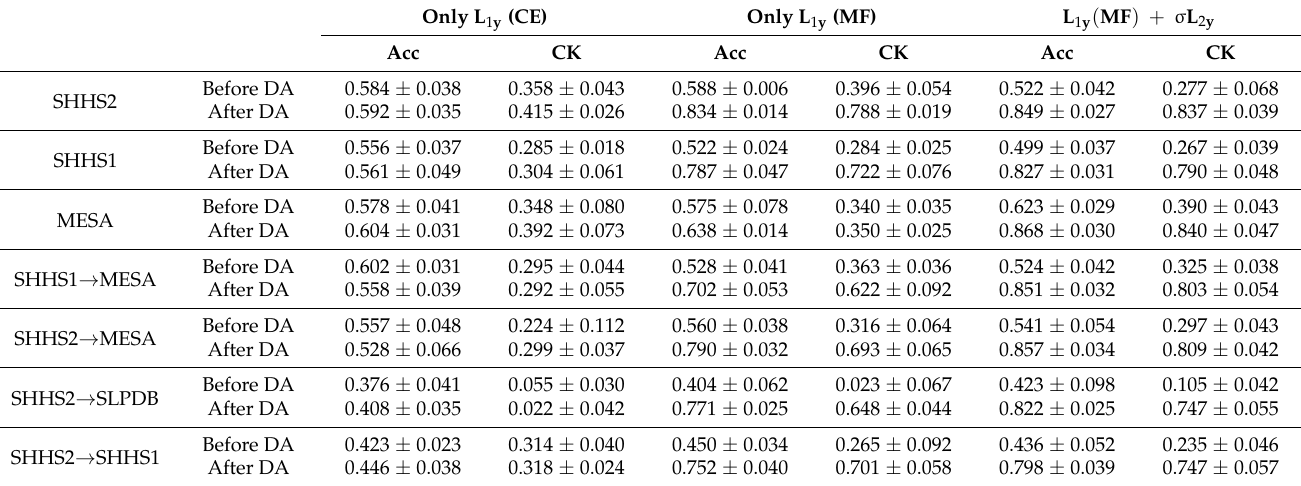
Table 7. The comparison results of different loss